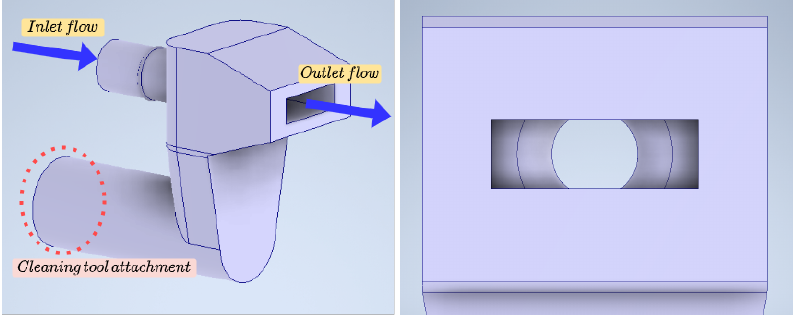
Figure 3. Nozzle with variable cross-section design to increase range and dispersion.